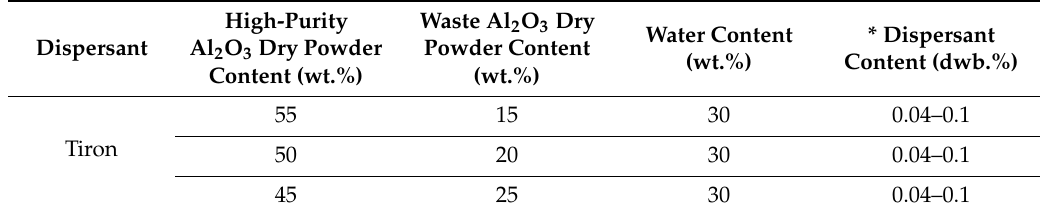
Table A1. Composition of prepared suspensions used in preliminary